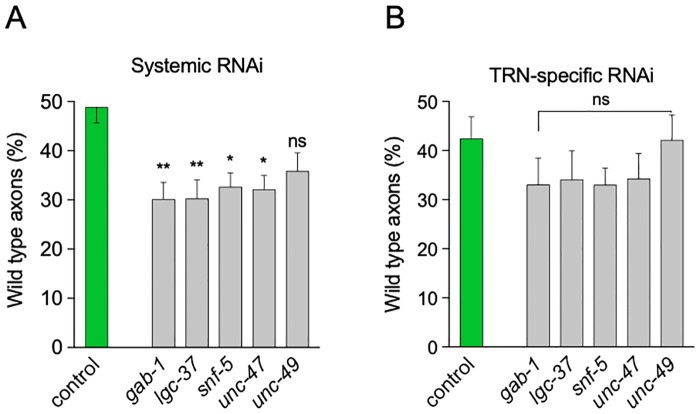
Effect of silencing GABA effectors in C. elegans on neuroprotection.Morphological integrity of AVM in animals feeding on dsRNA-expressing bacteria for the indicated genes in a systemic (A) and TRN-autonomous (B) RNAi strain. **P < 0.005, *P < 0.05; ns. The underlying numerical data and statistical analysis for each figure panel can be found in S1 and S2 Datasets, respectively. AVM, anterior ventral microtubule; dsRNA, double-stranded RNA; GABA, γ-aminobutyric acid; gad, glutamate decarboxylase enzyme gene; ns, not significant; RNAi, RNA interference; TRN, touch receptor neuron.